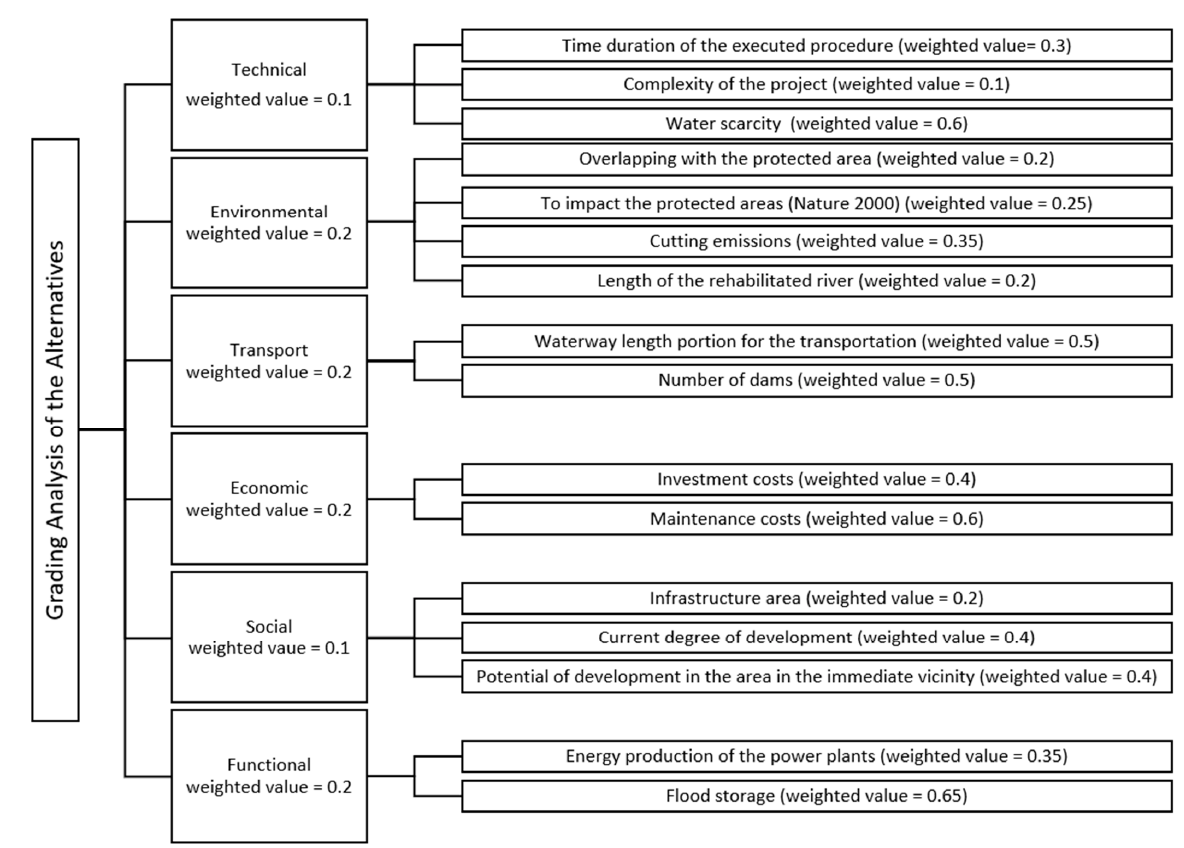
Figure 2. The flowchart related to grading the alternatives based on their main criteria and sub- criteria [45].